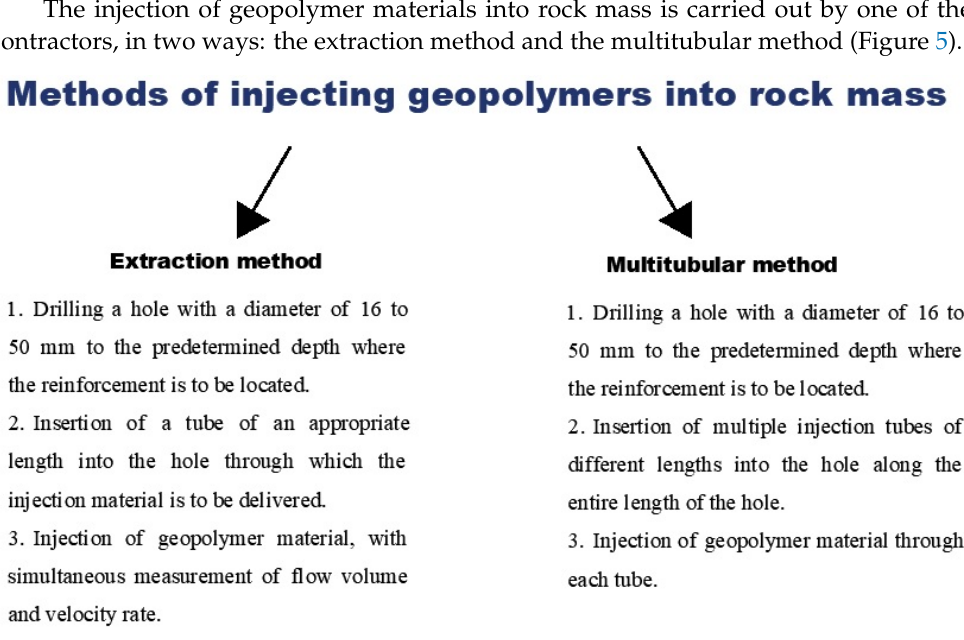
Figure 5. Methods of injecting geopolymer materials. Adapted from [48].